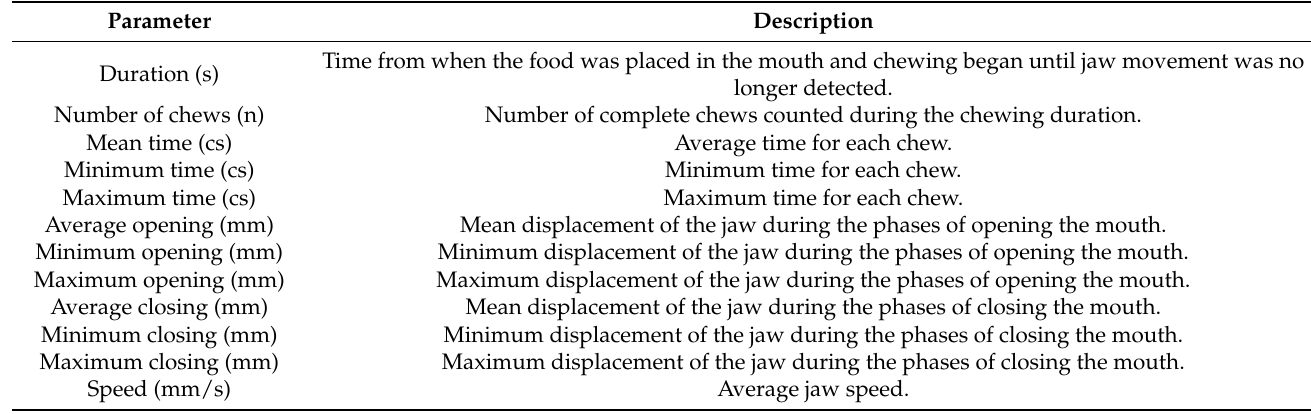
Table 2. Parameters analysed during the kinematics of oral